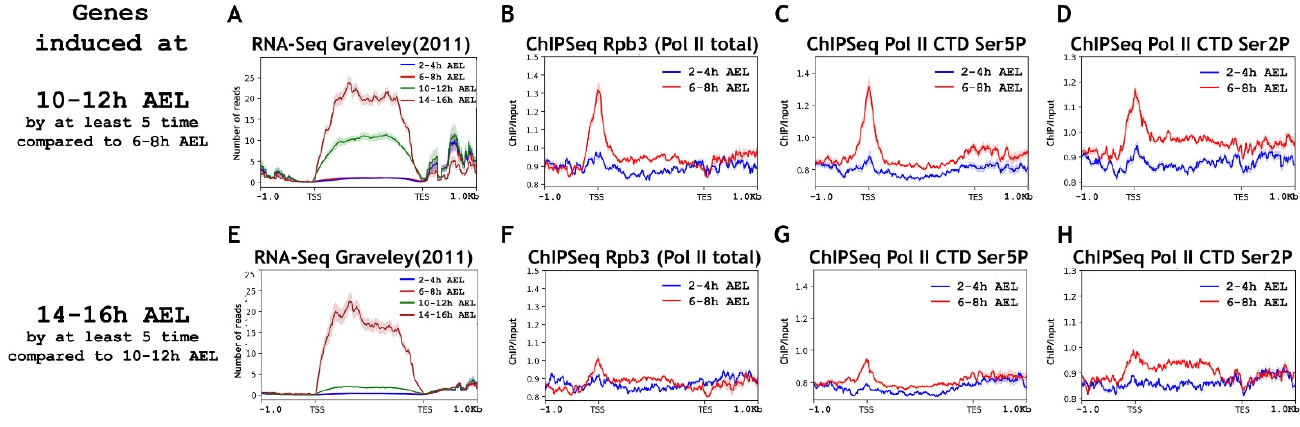
Figure 3. Average binding profiles of various Pol II isoforms on genes induced at the 10–12 h and 14–16 h AEL (after eggs laying) stages of Drosophila embryogenesis. Average of the ( A ) RNA-seq signal and an average distribution of ( B ) Rpb3 (Pol II subunit), ( C ) Pol II Ser5P CTD, and ( D ) Pol II Ser2P CTD binding across the genes induced at 10–12 h AEL (after egg laying) of Drosophila embryogenesis (total 462 genes/1188 transcripts). Average of the ( E ) RNA-seq signal and an average distribution of ( F ) Rpb3 (Pol II subunit), ( G ) Pol II Ser5P CTD, and ( H ) Pol II Ser2P CTD binding across the genes induced at 14–16 h AEL (after egg laying) of Drosophila embryogenesis (total 548 genes/1379 transcripts). ChIP-Seqs were performed on whole embryos of 2–4 h (blue line) and 6–8 h (red line) after eggs laying (AEL). Pools of “10–12 h AEL genes” and “14–16 h AEL genes” were selected according to the common rule, to be induced at least five times compared with “6–8 h AEL” and “10–12 h AEL” stages, respectively. Protein binding levels were calculated as an enrichment (ratio of the corresponding ChIP-Seq signal to the input DNA). Average profiles were generated using the metagene mode (introns were ignored and gene bodies were scaled to 2 kb) and calculated as the median of the protein binding signal. Average profiles of the RNA-seq signal were calculated as the mean level. The standard error appears on the graphs as a lighter area around the main line of the profiles. Abbreviations: TSS: transcription start site; TES: transcription end